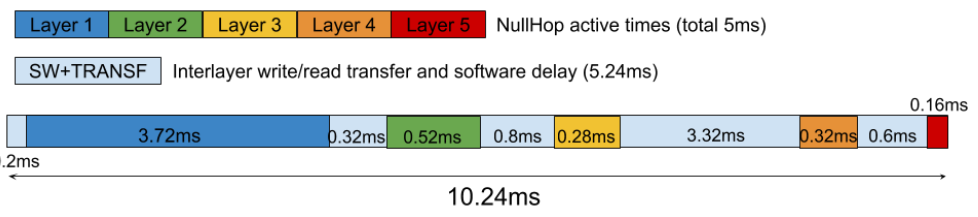
Figure 5. Roshambo computing time scheme on Nullhop hardware accelerator using the AXI-DMA Linux native